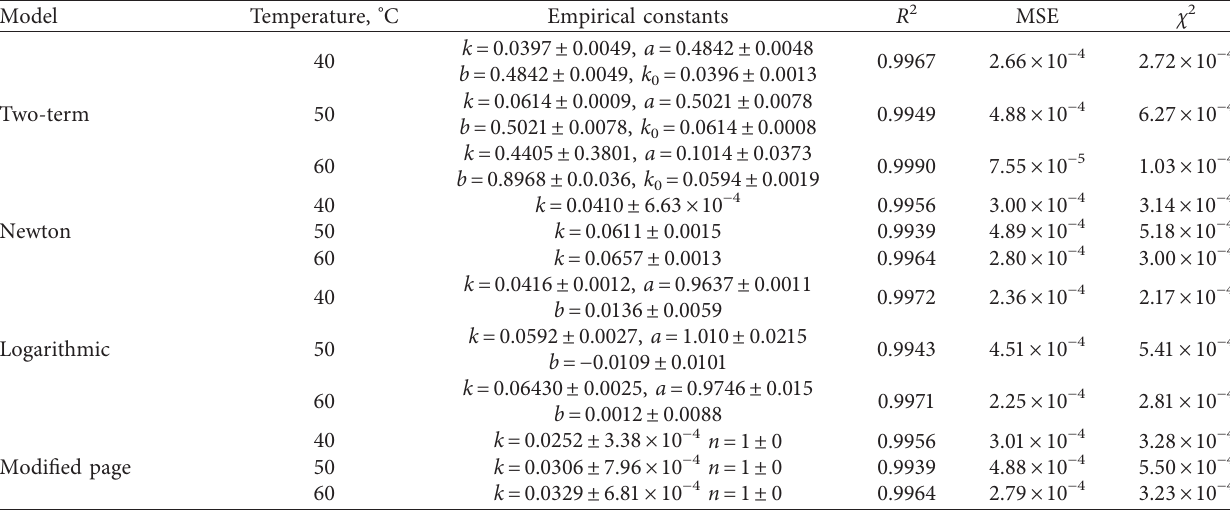
Figure 2: Drying characteristics of pumpkin seed in VFBD: change in (a) moisture content, (b) drying rate, and (c) moisture with drying time. Table 4: Statistical parameters and the coefficients of pumpkin seeds dried in